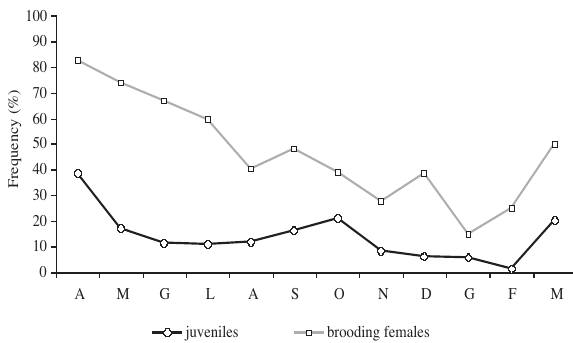
brooding females F IG . 3. – Monthly variations in frequency (%) of brooding females (expressed as a percentage of the total number of females) and juveniles (as a percentage of the total number